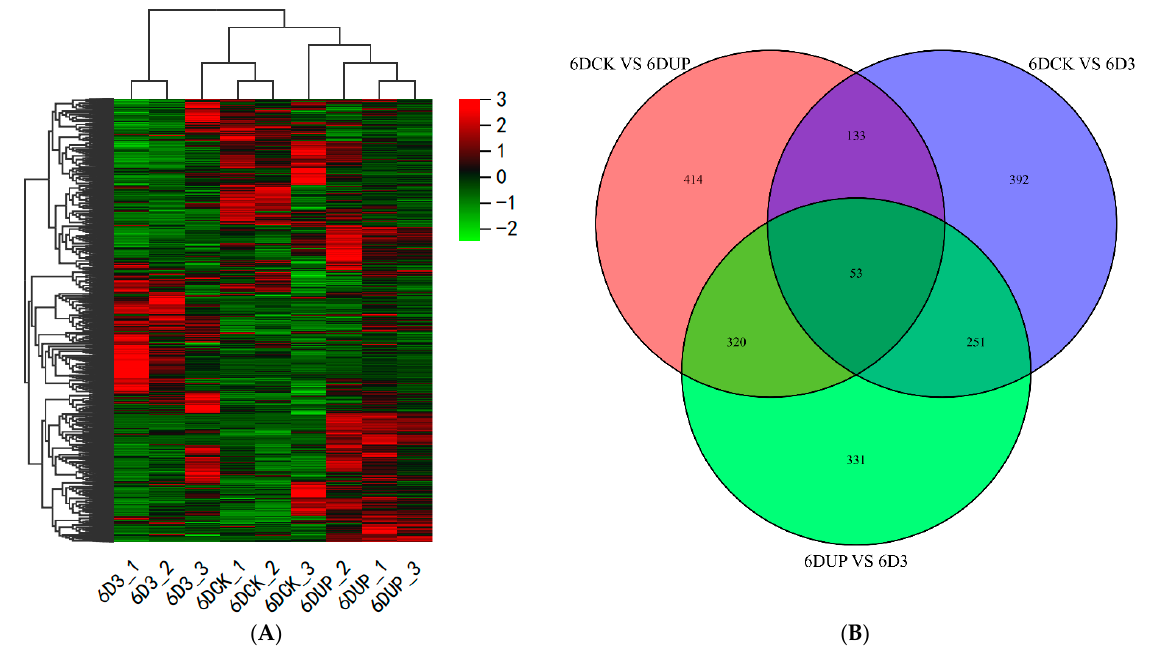
Figure 4. Differentially expressed genes (DEG) in kiwifruit ( Actinidia chinensis ) ‘Donghong’ in response to different treatments during fruit ripening stages. ( A ) The heatmap of DEGs from different treatments. ( B ) Venn enrichment analysis of DEGs.